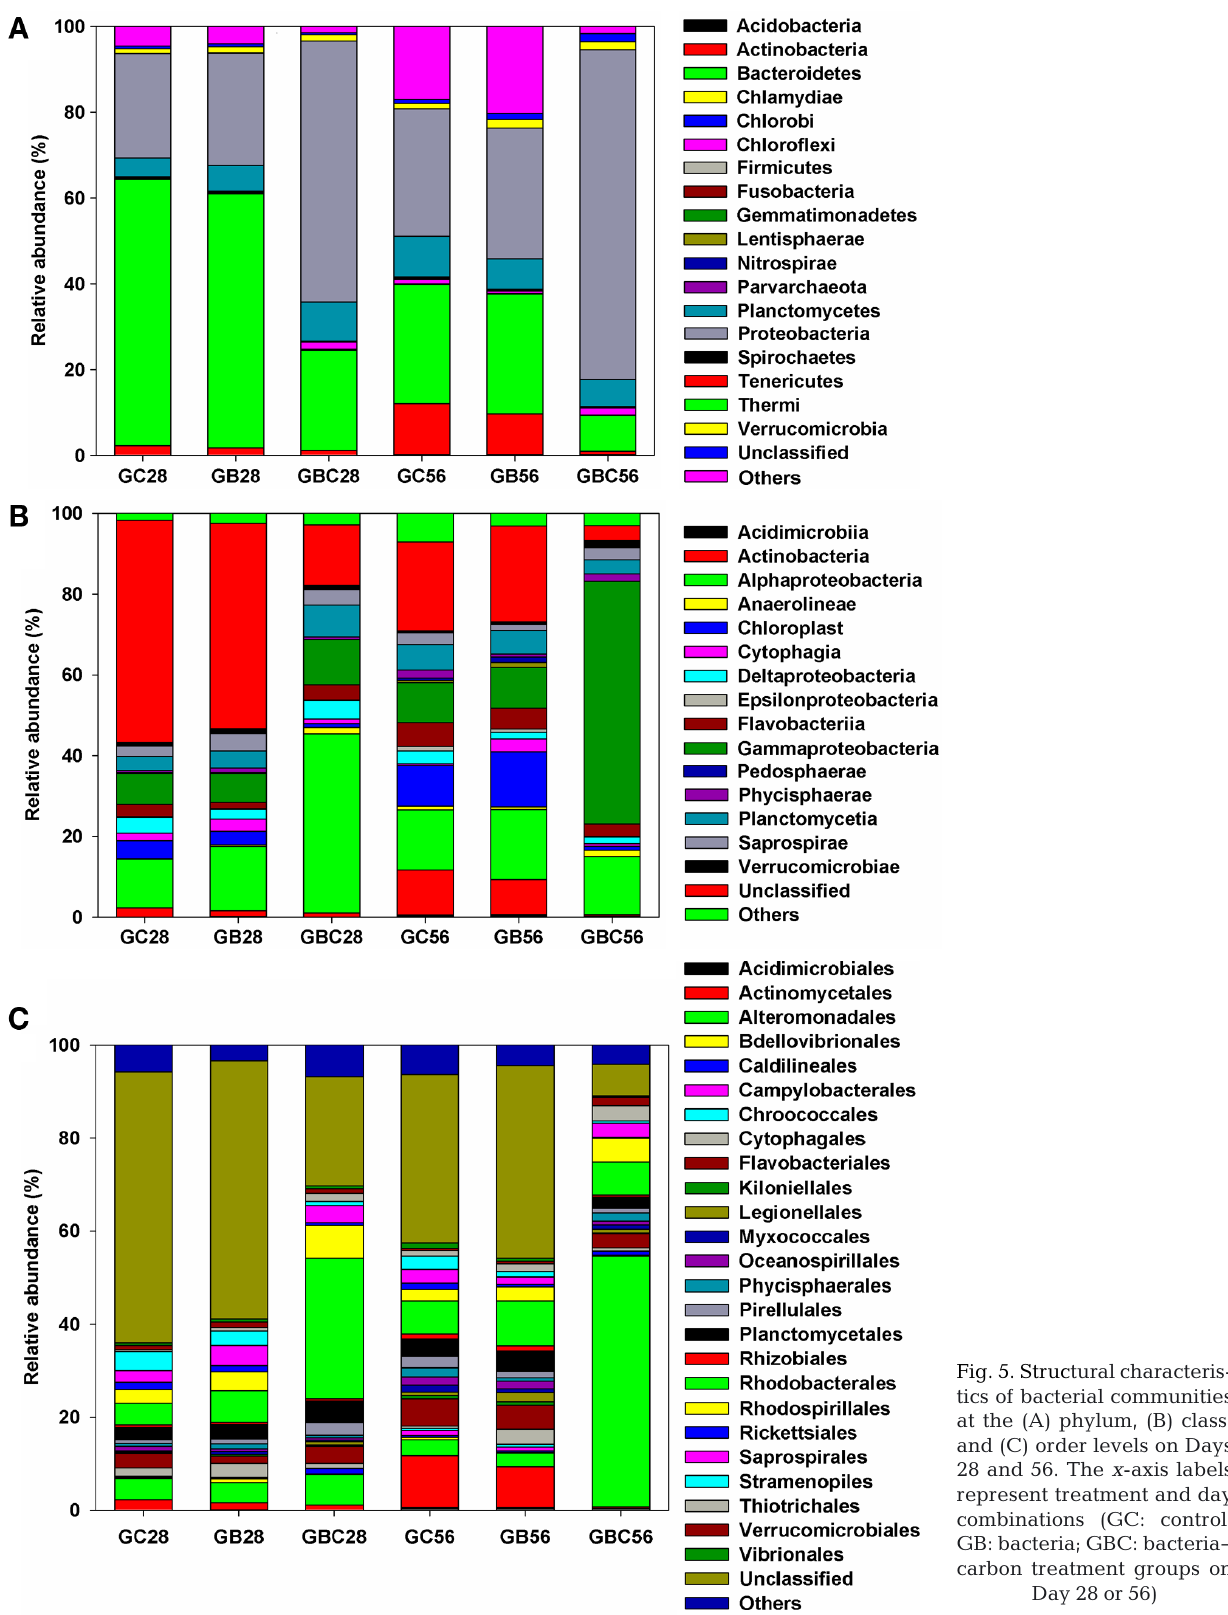
Fig. 5. Structural characteris- tics of bacterial communities at the (A) phylum, (B) class, and (C) order levels on Days 28 and 56. The x -axis labels represent treatment and day combinations (GC: control; GB: bacteria; GBC: bacteria− carbon treatment groups on Day 28 or